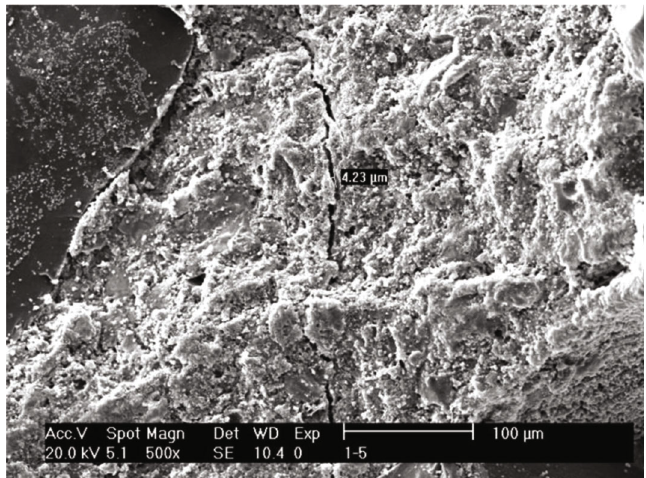
Figure 9: SEM imaging of simulated